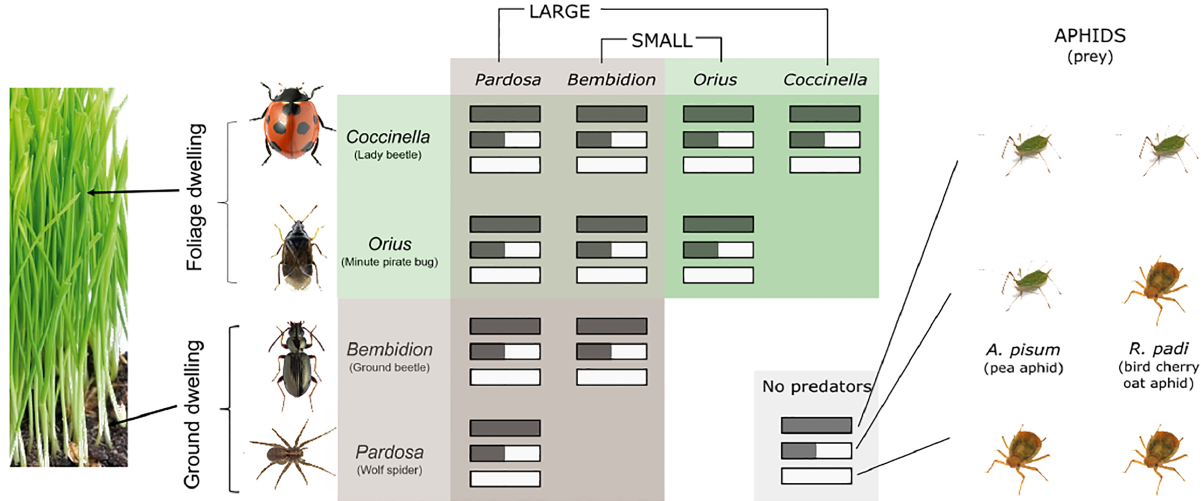
Fig 1. An overview of the experimental design and the hypotheses we test. We select two predators which reside primarily in the foliage and two on the ground. Of those two, one is large and one is small such that each combination of size and habitat use is covered. Each predator is combined with each other predator, including itself, to cover all one- and two-predator combinations. We also select two species of prey, and within each predator combination, each prey combination is represented (shown by horizontal bars of one or two colors). Thus, including controls containing no predators, we have 33 predator-prey